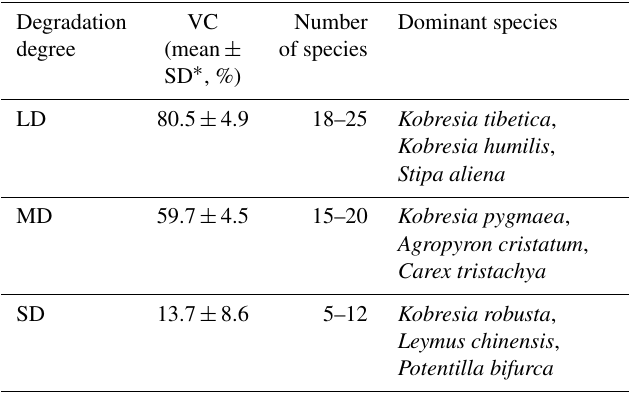
Table 1. Vegetation characteristics of investigated sites in this study. Degradation VC